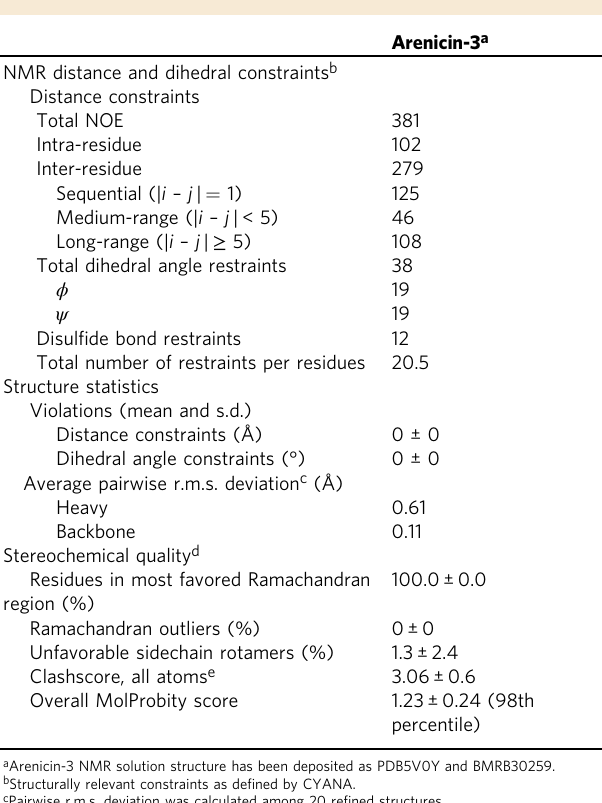
Table 1 NMR and re fi nement statistics for arenicin-3 solution